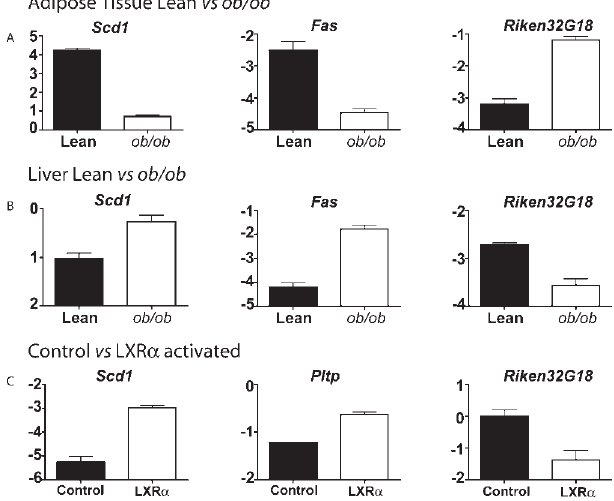
Figure 5. Regulation of Riken32G18 Inversely Parallels the Regulation of Lipogenic Genes (A) Metabolic regulation of Riken32G18 . Expression of lipogenic genes and Riken32G18 in adipose tissues of lean versus obese mice. (B) Expression of lipogenic genes and Riken32G18 in livers of lean versus obese mice. (C) Expression of LXR a target genes and Riken32G18 in mouse livers treated with LXR a agonist T0901317. DOI: